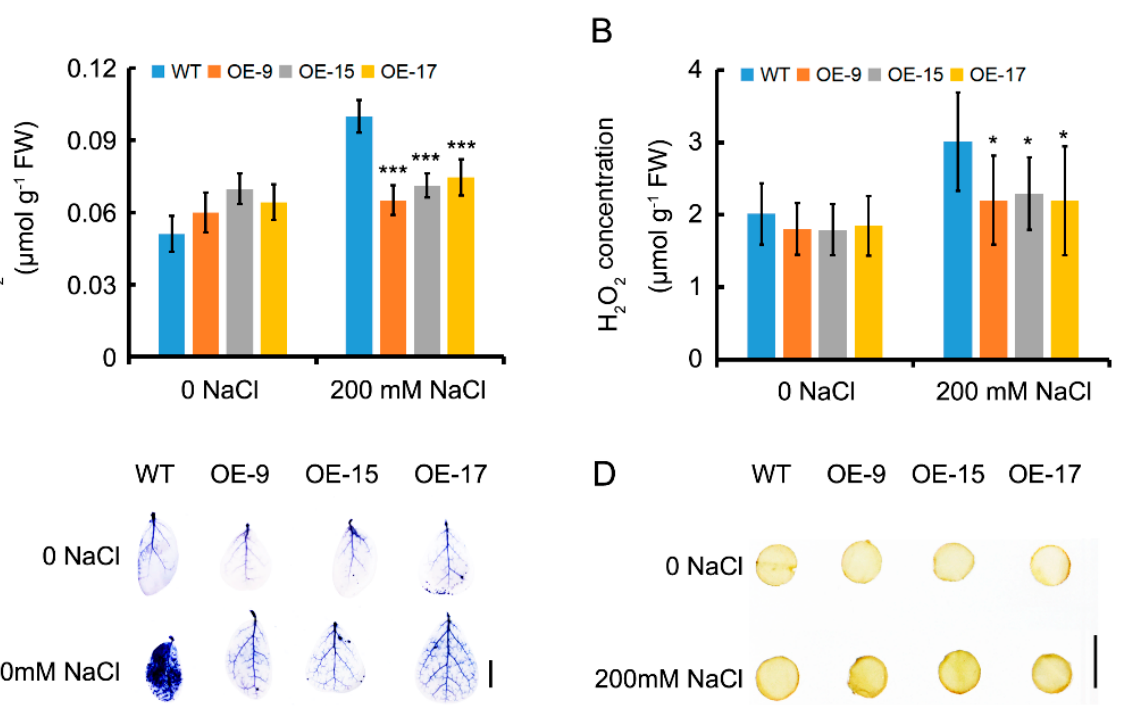
Figure 4. Changes in ROS concentration after salt treatment. ( A ) NBT staining of leaves. ( B ) DAB staining of leaves. ( C ) O 2 − concentration in the leaves. ( D ) H 2 O 2 concentration in the leaves. Three- week-old seedlings were treated with 200 mM NaCl and leaves were collected for staining and measurement of ROS 6 days after treatment. Error bars represent the SD of six biological replicates. Scale bar = 0.5 cm in ( A , B ). The significant differences were assessed using one-way ANOVA (*, p < 0.05; ***, p < 0.001).